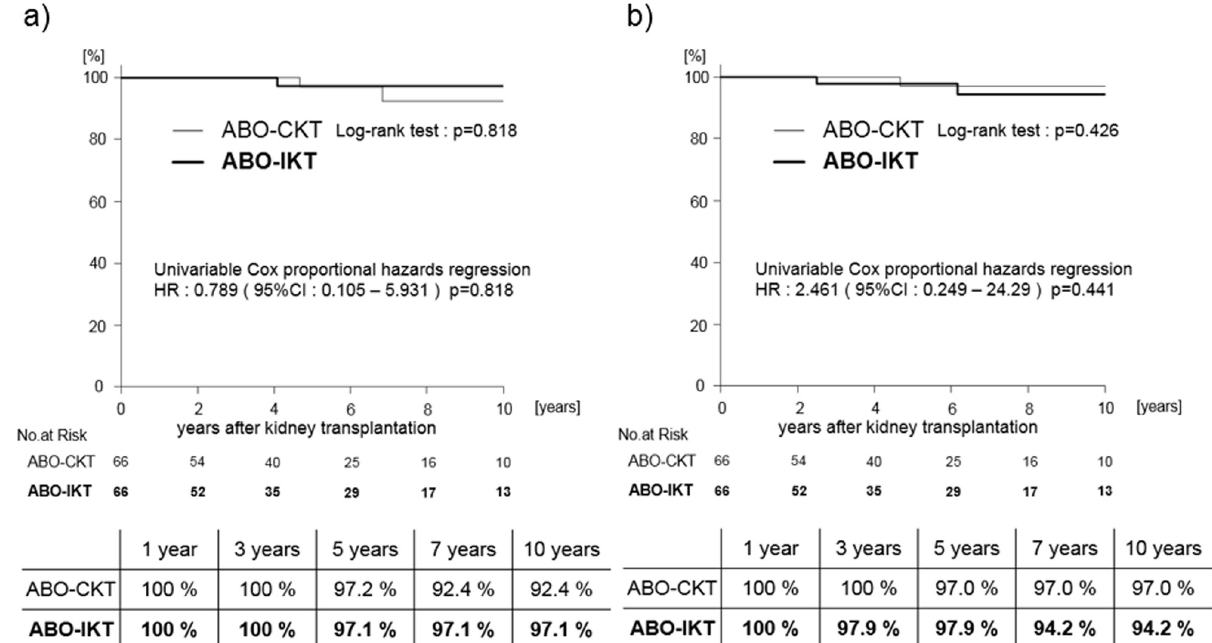
Fig 4. Patient and graft survival rates of ABO-CKT and ABO-IKT after propensity score matching. (a) Patient survival rates (b) Graft survival rates. ABO-CKT; ABO-compatible kidney transplantation, ABO-IKT; ABO-incompatible kidney transplantation.